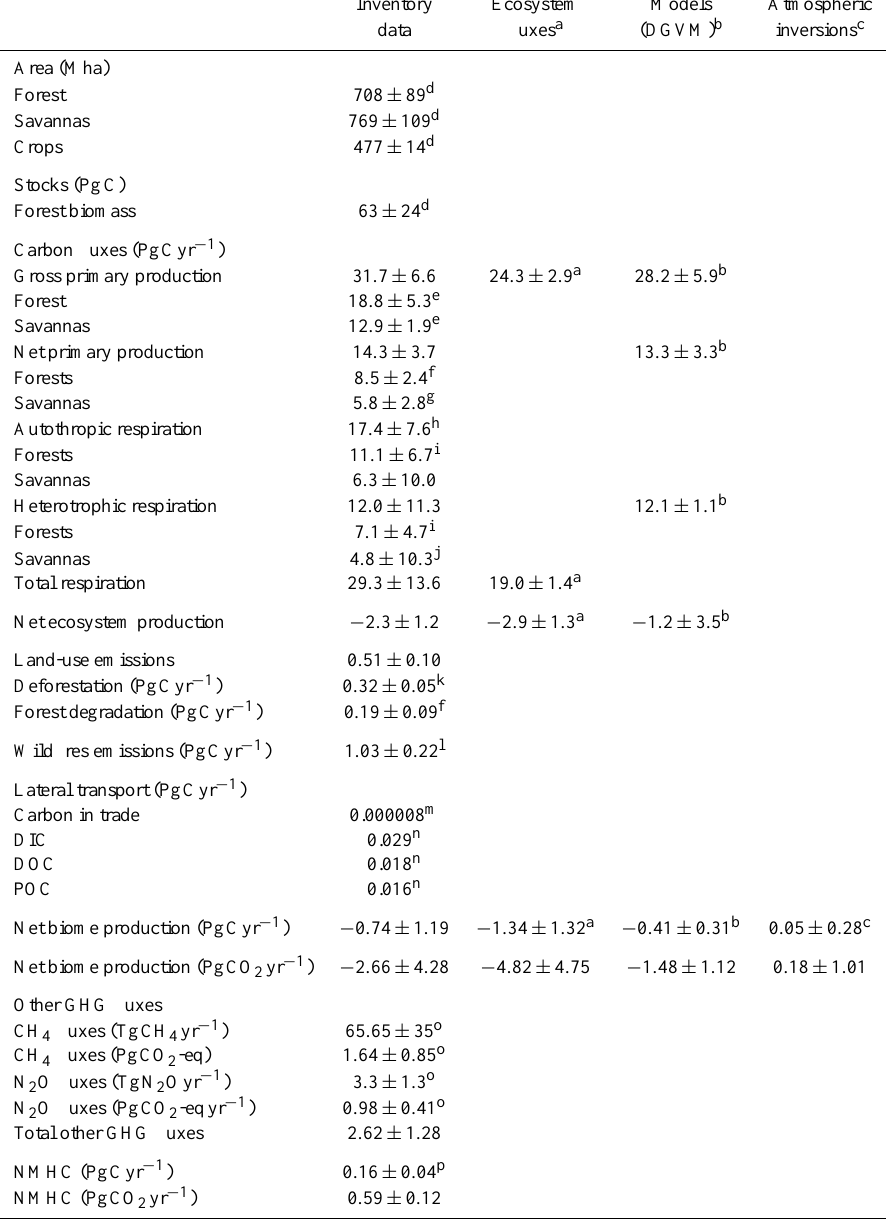
Table 11. Synthesis of current estimates of GHG and carbon fluxes and pools in Africa. All these values do not include fossil fuel emissions. Reference periods are indicated in the